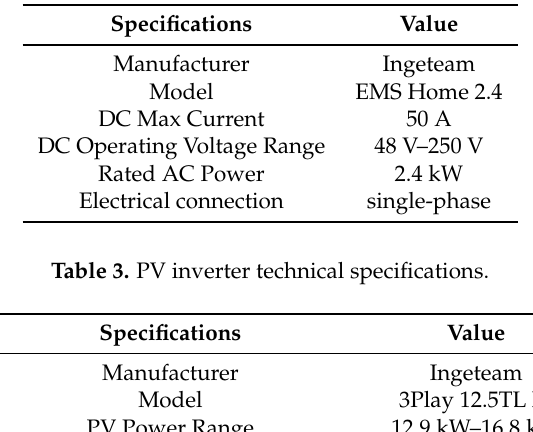
Table 2. Battery inverters technical specifications.